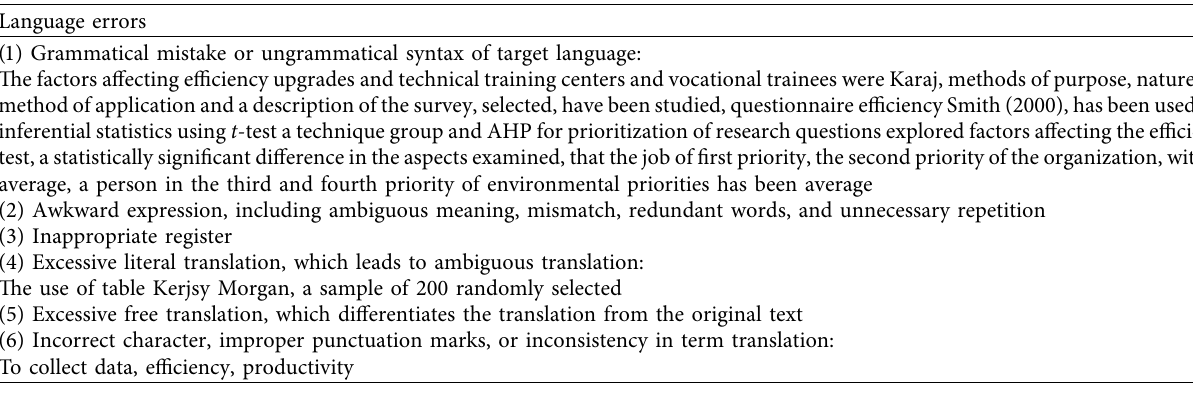
Table 3: Language errors related to Sample 2.